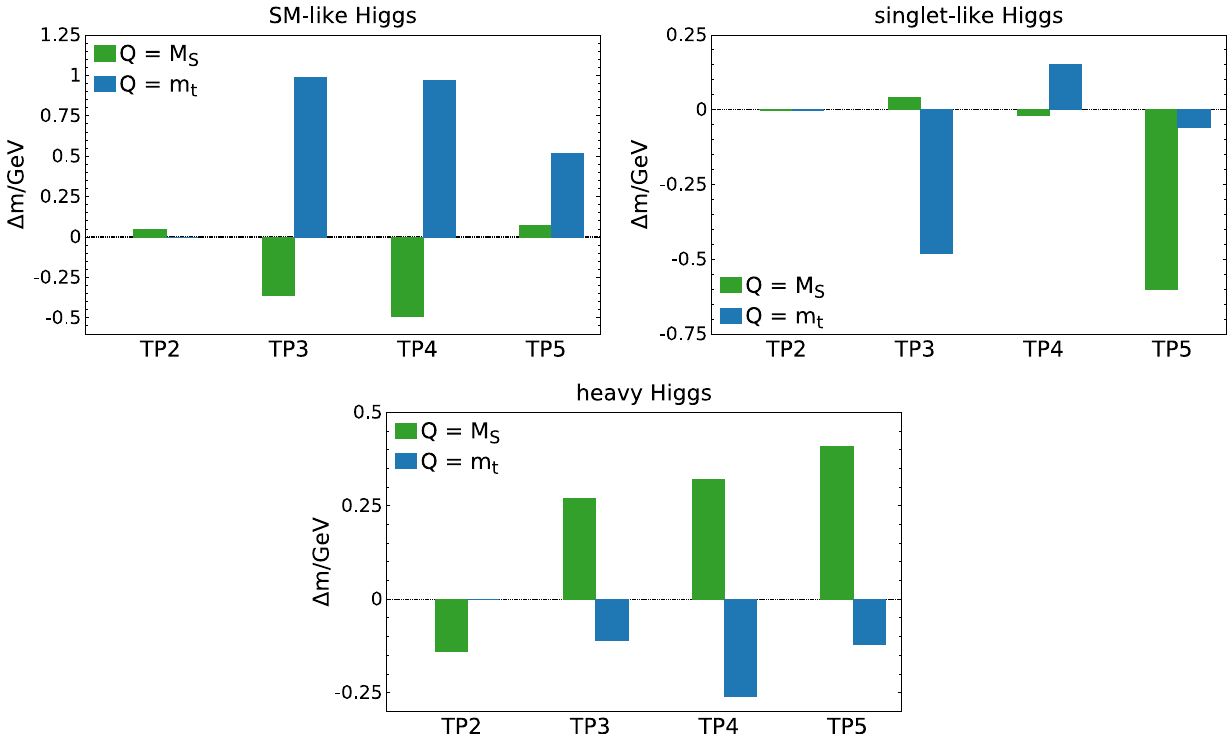
− M N-FH Fig. 4 Difference (cid:9) m = M NC α s mod between the Higgs masses of the SM-like, singlet-like and heavy Higgs at the two-loop level h h calculated at the scales M S and m